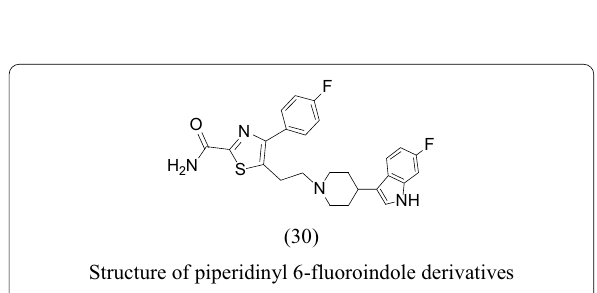
Fig. 33 Structure of piperidinyl 6‑fluoroindole